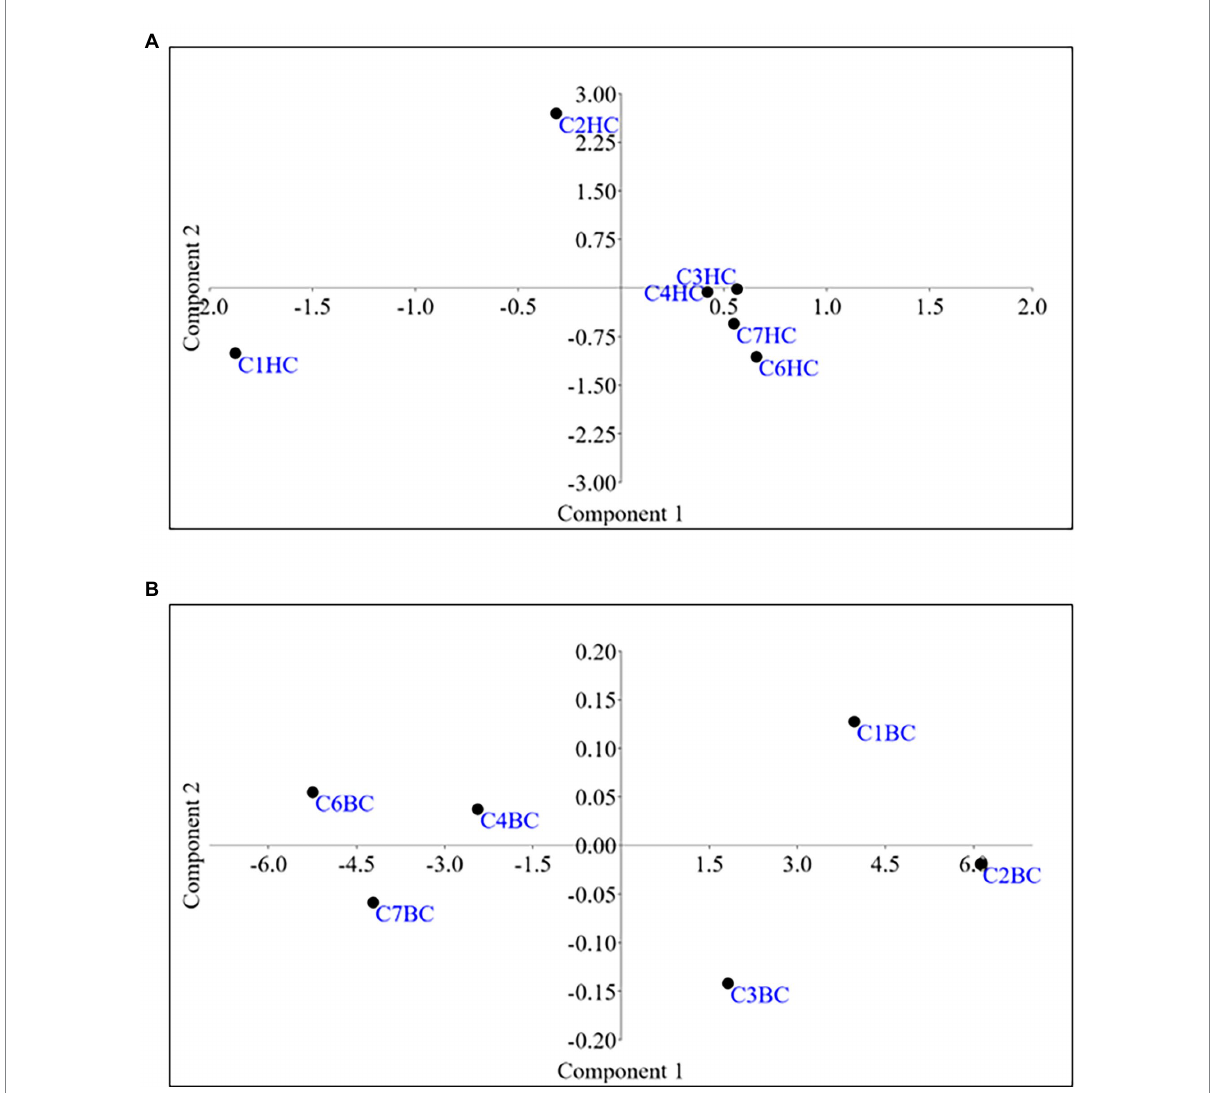
FIGURE 2 Principal Component Analysis for (A) HC/ (B) BC enrichments based on the growth